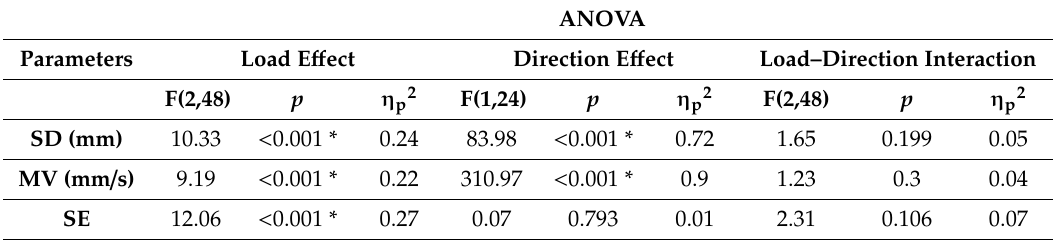
Table 2. Main e ff ects and interactions from analysis of